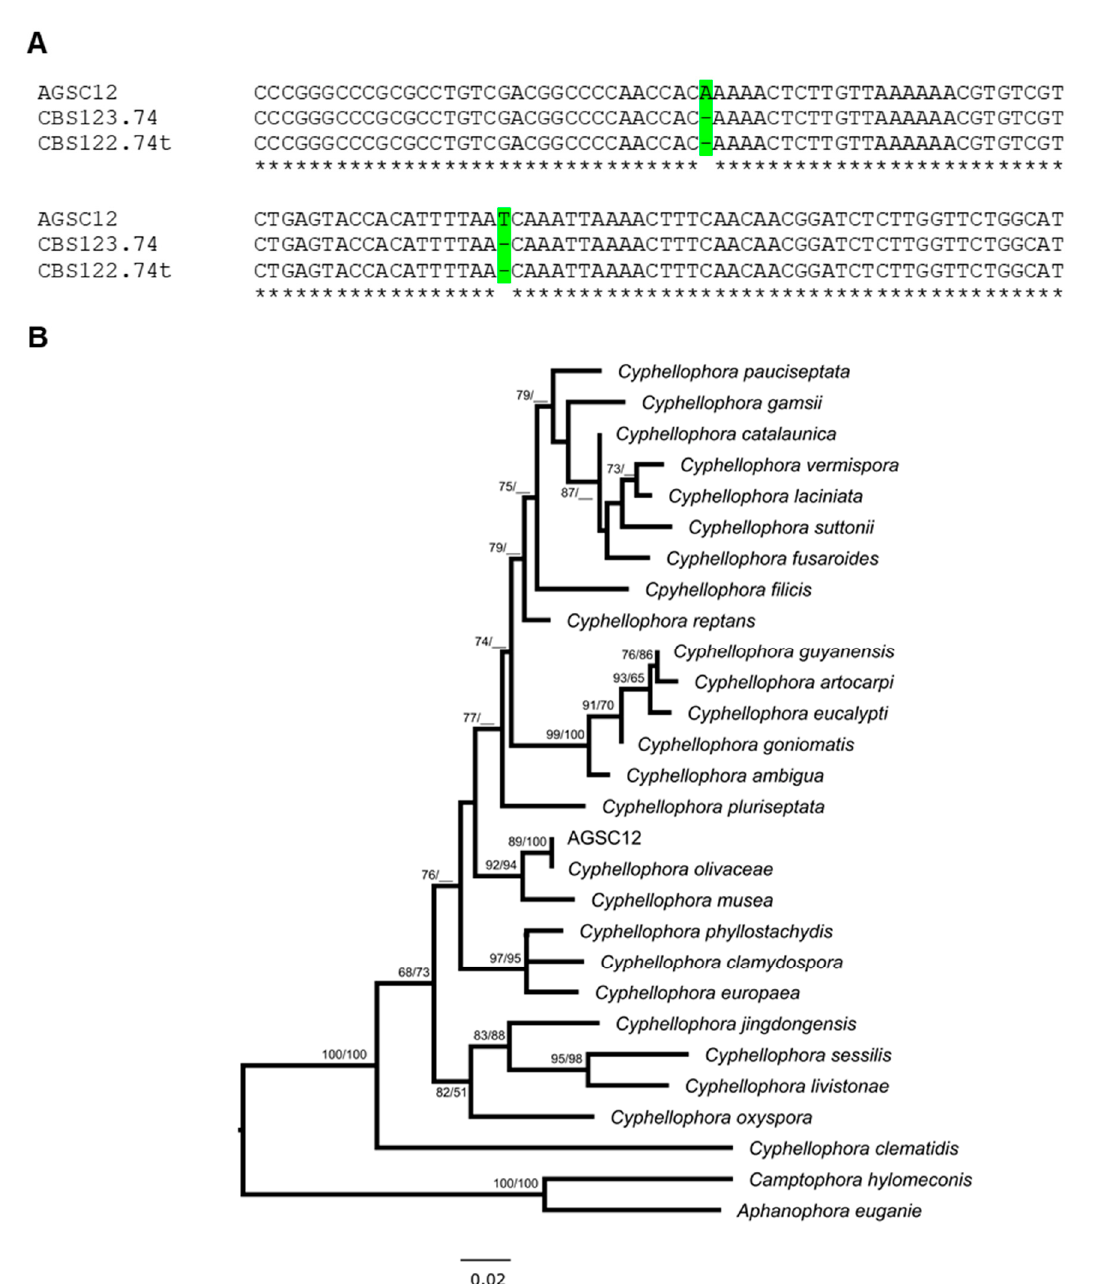
Figure 2. ( A ) Multiple sequence alignment of the ITS1-5.8SrDNA-ITS2 regions of the strain AGSC12 and C. olivacea strains CBS122.74 (ex-type strain) and CBS123.74. Only those regions are depicted from the alignment, which exhibited discrepancies (highlighted with green). Otherwise, the alignments were identical. ( B ) Phylogenetic analyses of the strain AGSC12 and other Cyphellophora species. The numbers at the branches indicate aLRT of Maximum Likelihood (ML) analysis, the other values come from bootstrapping of neighbour joining (NE) analysis (aLRT/bootstrap). Only aLRT and bootstrap values larger than 50 are shown. The current tree layout represents the ML analysis and comparison of ML. NJ can be seen in Supplementary Figure S1. Although some minor differences can be seen at the branching points, the strain AGSC12 clustered to the same branch with the C. olivacea ex-type strain in both the ML and NJ